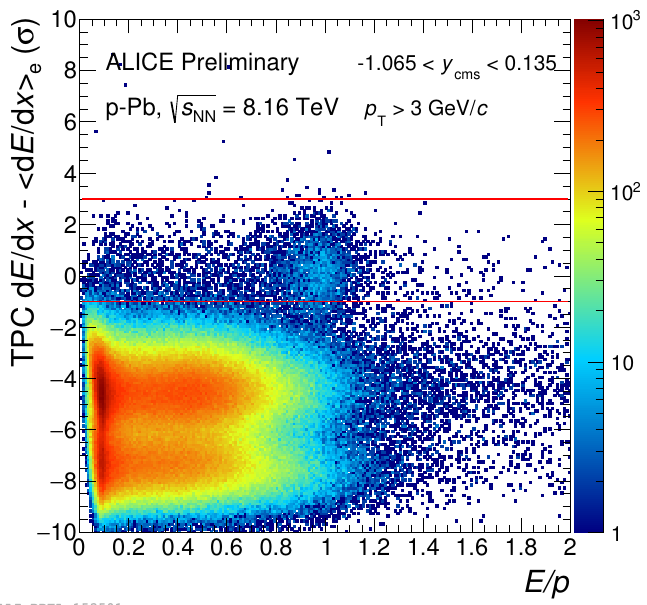
Figure 1. TPC n σ as a function of E / p in minimum-bias